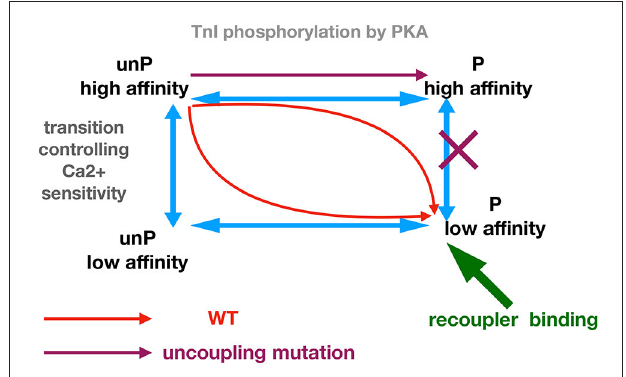
FIGURE 6 | Allosteric model for modulation of Ca 2 + -sensitivity by phosphorylation, mutations, and small molecule recouplers.